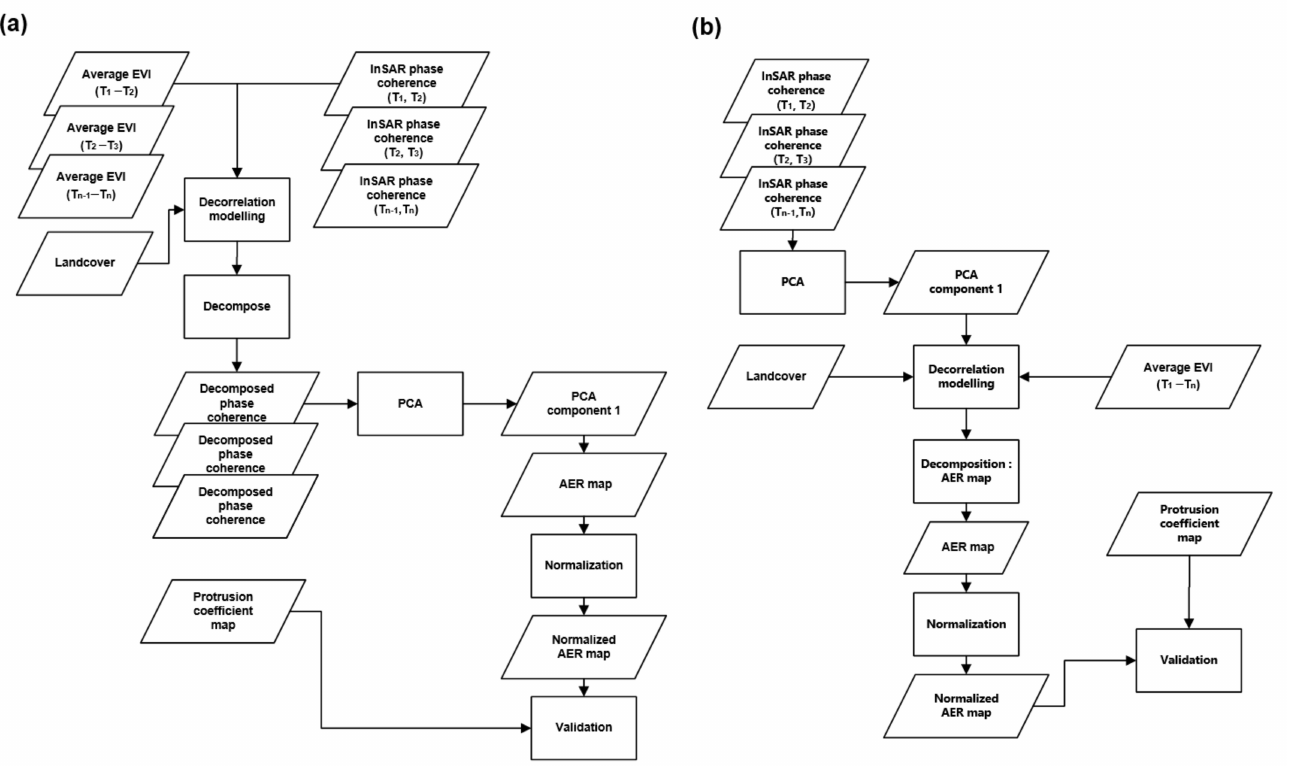
Figure 2. ( a ) Processing flow of phase coherence analyses for the establishment of the AER map using decomposed phase coherence, which is called a prior processor, ( b ) Processing flow of phase coherence analyses for the establishment of the AER map using the 1st principal component analysis (PCA) component and its decomposition, which is hereafter referred to as the posterior